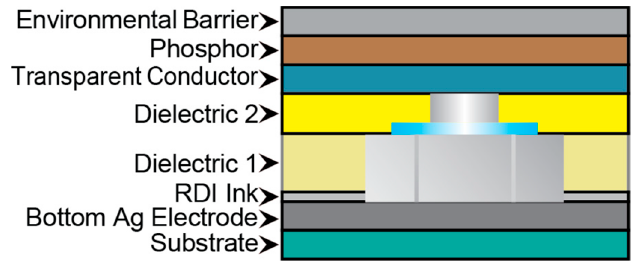
Figure 2. Layer build for printed LEDs.